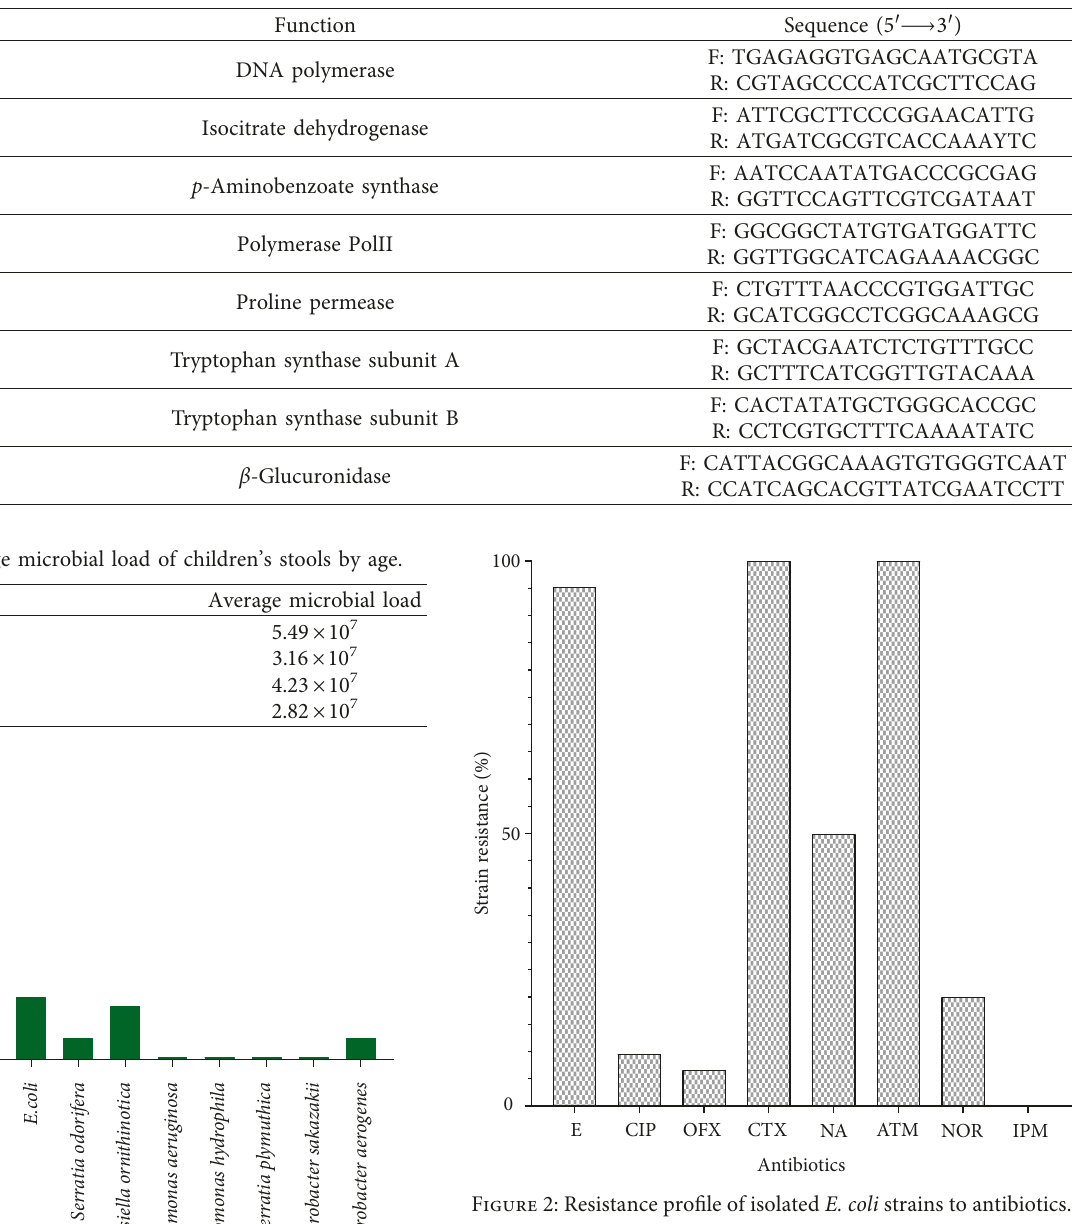
Table 1: Sequences of primers [19] used for characterization of isolated Escherichia coli strains.